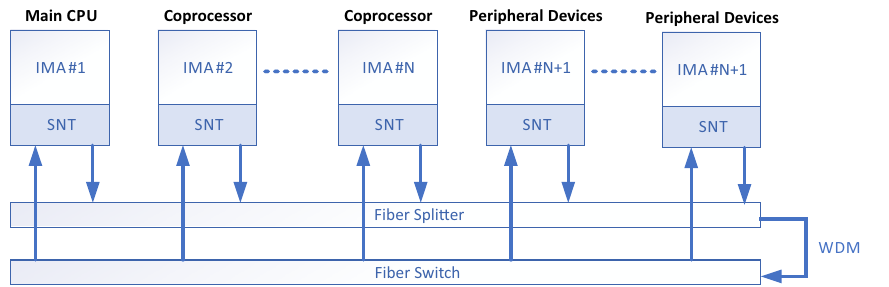
Figure 13. Topology of the all-optical onboard